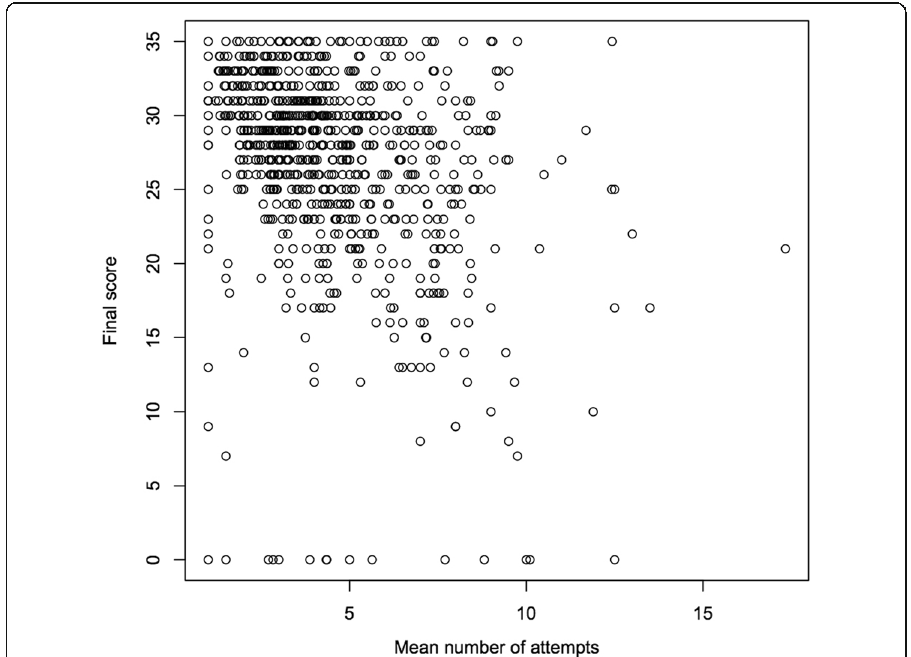
Fig. 2 Scatterplot over the mean number of attempts and final test